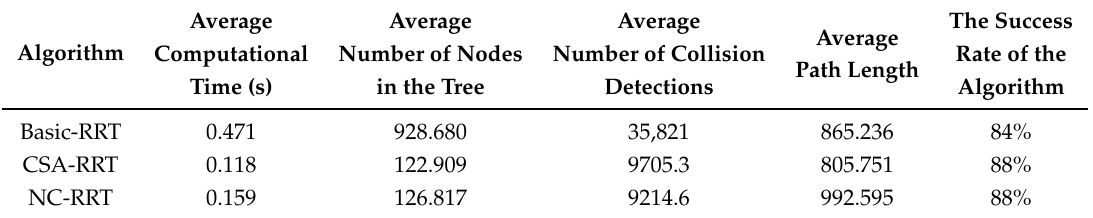
Table 2. Simulation results of the three algorithms in the trapped environment. ( k = 3, c = 2 ) .